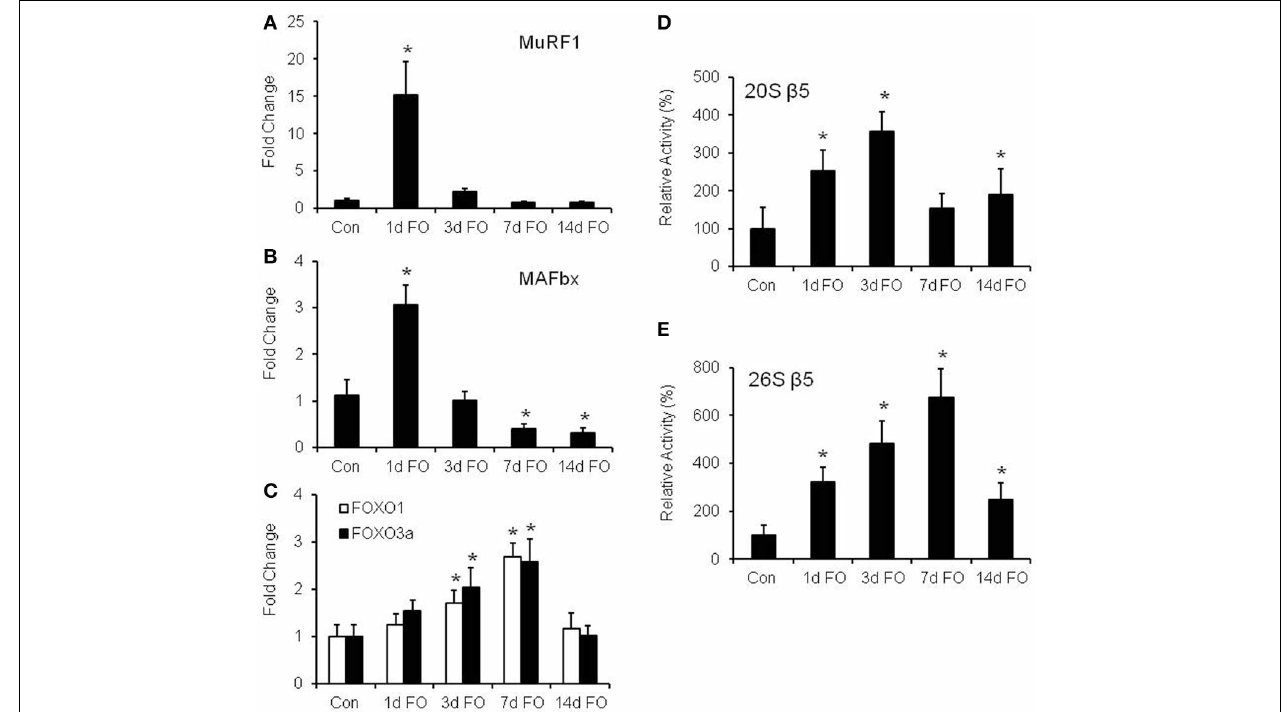
FIGURE 4 | Functional overload (FO) induces a proteolytic response in the plantaris muscle. mRNA expression of (A) MuRF1, (B) MAFbx, and (C) FOXO1, and FOXO3a was measured in WT mice following no treatment (Con) and FO for 1, 3, 7, or 14 days. Expression values were normalized to GAPDH and are expressed as a fold change (mean ± SD ) relative to control